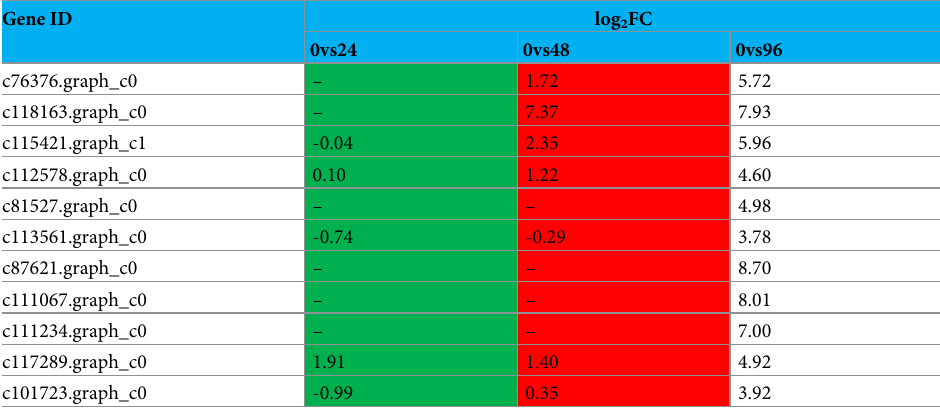
Table 3. Response of LEA genes to drought